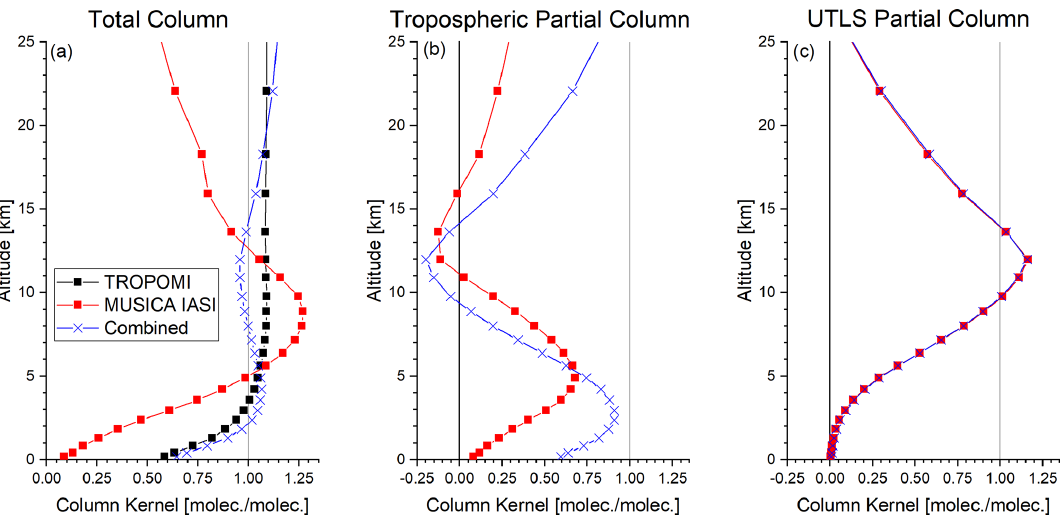
Figure 3. Total-column and partial-column amount kernels corresponding to the TROPOMI, MUSICA IASI, and the combined product for the same late summer observation as used in Figs. 1 and 2: (a) total-column amount kernels; (b) lower tropospheric partial-column amount kernels, surface − 6kma.s.l.; and (c) upper troposphere–lower stratosphere (UTLS) partial-column amount kernels,